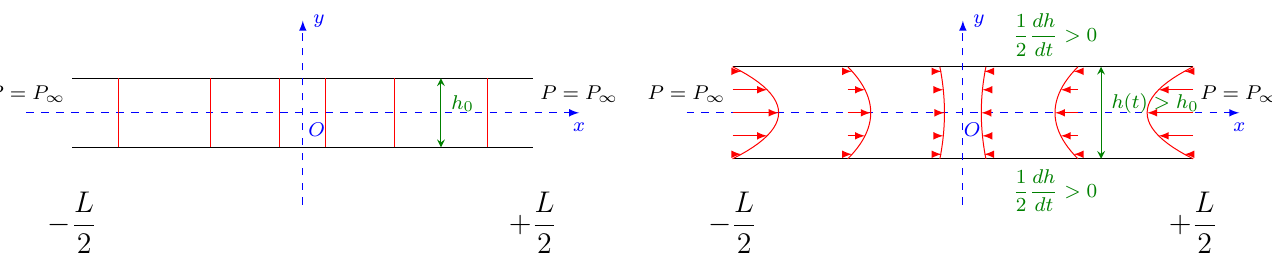
Figure 2: Fluid in steady state (left) and movement induced by moving boundaries